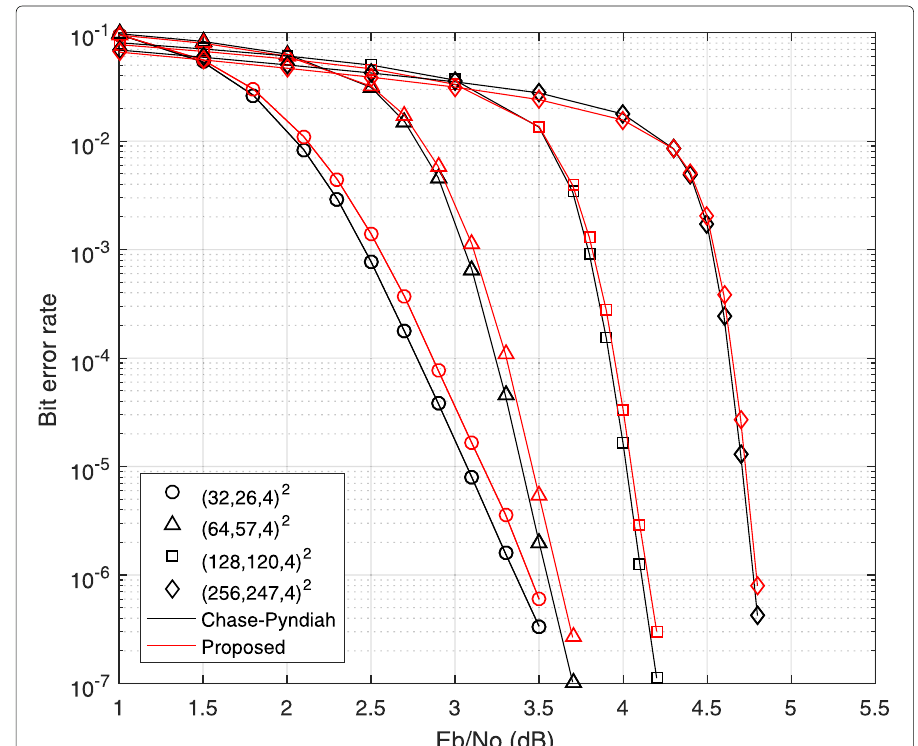
Fig. 12 Error correction performance results of the Chase-Pyndiah and the proposed decoding algorithm in three kind of TPCs ( I max ,8; LRB number,